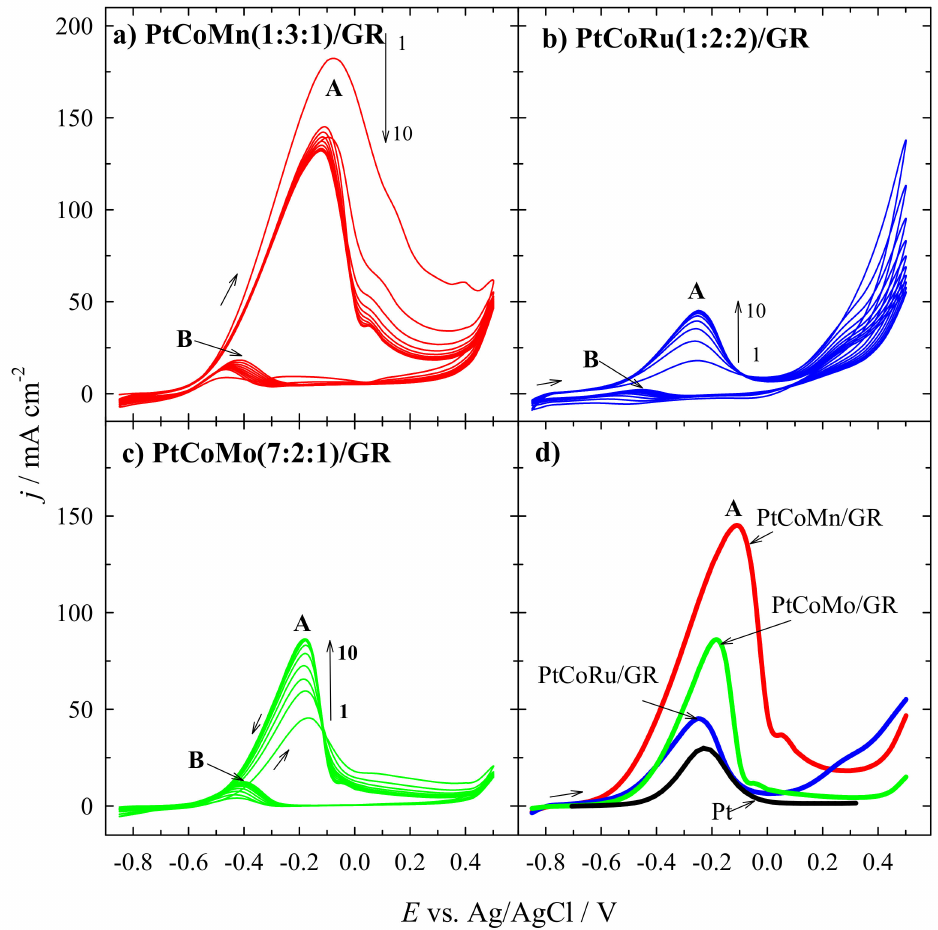
Figure 5. CVs of PtCoMn(1:3:1)/GR ( a ), PtCoRu(1:2:2)/GR ( b ), and PtCoMo(7:2:1)/GR ( c ) catalysts recorded in 1 M CH 3 OH + 1 M NaOH at 50 mVs − 1 . Comparison of positive-potential going scans of the PtCoM/GR and Pt/GR catalysts ( d